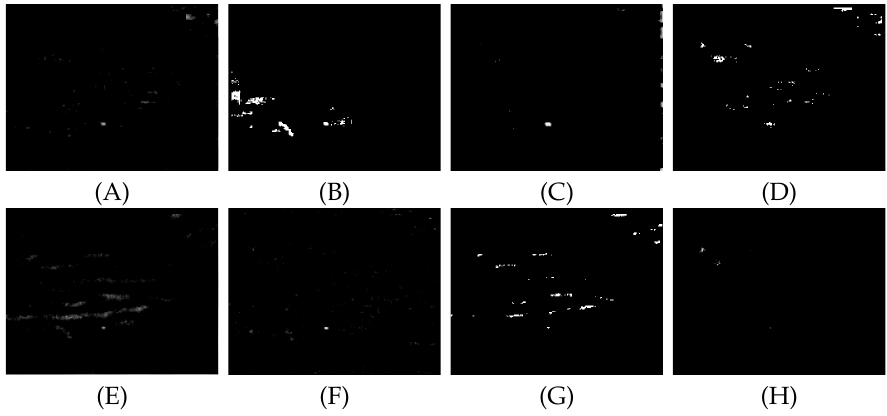
Figure A14. ( A – H ) shows the detection results of eight algorithms PSTNN, TV-PCP, VNTFR, anisotropy, ASTTV, SRWS, RPCA and propose method, respectively, under sequence